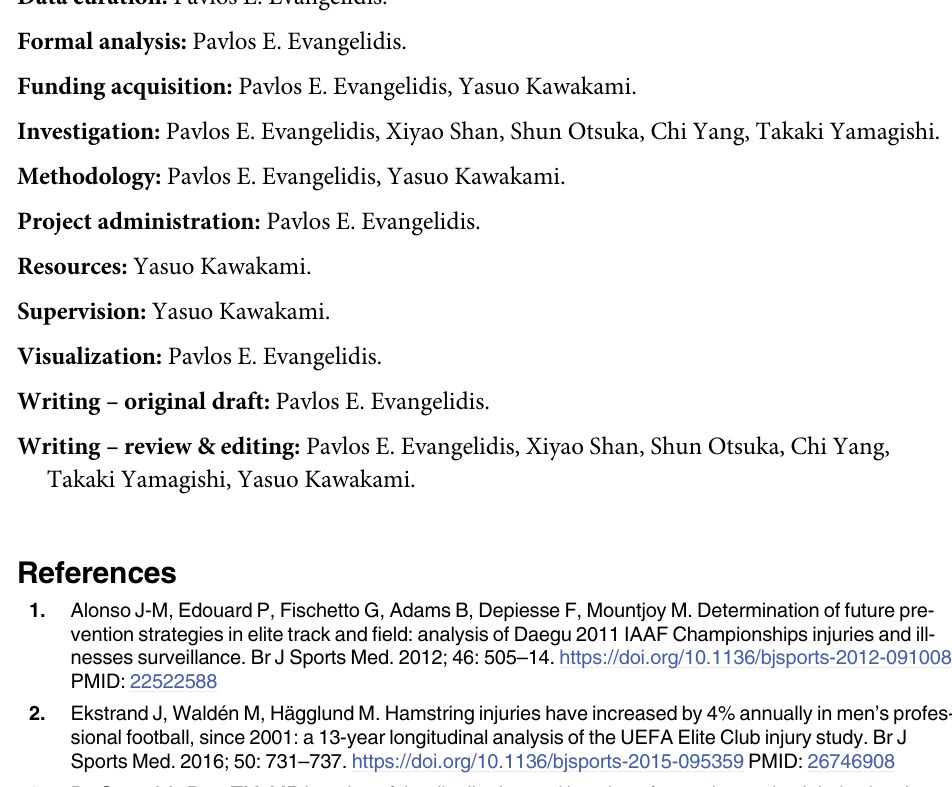
S2 Table. Descriptive and reliability statistics for hamstrings SWV in concentric condition. Descriptive statistics and absolute (TE, %TE) and relative (ICC) reliability measures for muscle shear wave velocity in isometric condition (CON). TE, typical error; ICC, intraclass correlation coefficient; CI, confidence interval; BFlh, biceps femoris long head; ST, semitendinosus; SM, semimembranosus. S3 Table. Descriptive and reliability statistics for hamstrings SWV in eccentric condition. Descriptive statistics and absolute (TE, %TE) and relative (ICC) reliability measures for muscle shear wave velocity in isometric condition (ECC). TE, typical error; ICC, intraclass correlation coefficient; CI, confidence interval; BFlh, biceps femoris long head; ST, semitendinosus; SM,